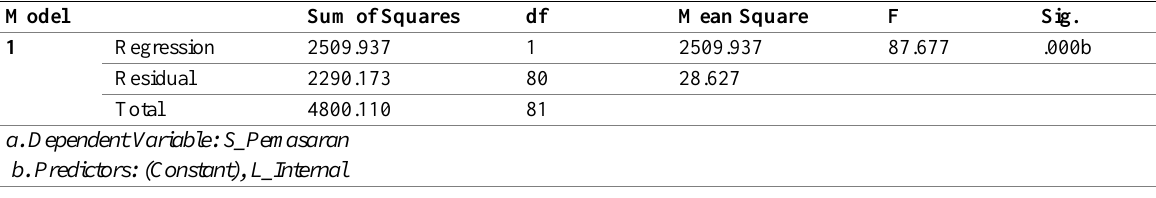
Table 3: F-Statistic and Prob. (F-Statistic) Model Structure I ANOVAa